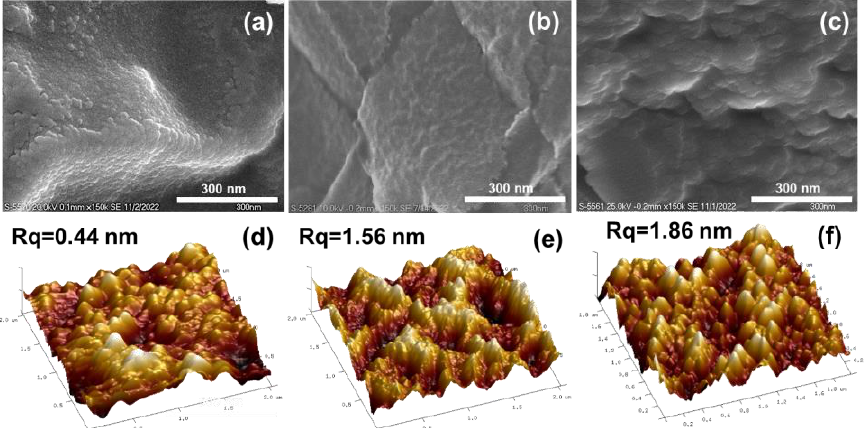
Figure 3. SEM images of PDMS-BWS-Ag SERS substrate (magnification of 150 K) with ( a ) 25 nm, ( b ) 30 nm, and ( c ) 35 nm. AFM 3D images of PDMS-BWS-Ag with ( d ) 25 nm, ( e ) 30 nm, and ( f ) 35 nm.